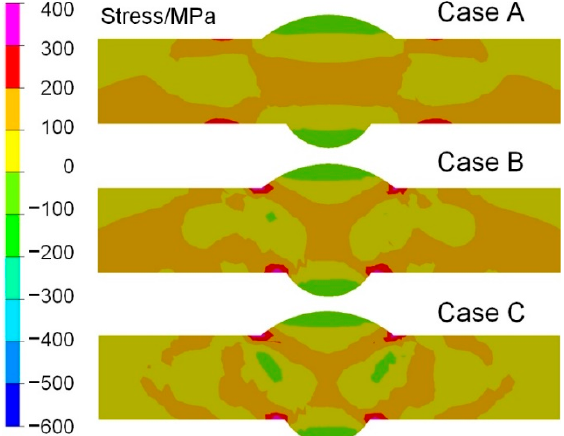
Figure 19. Transverse residual stresses distributions in central section.